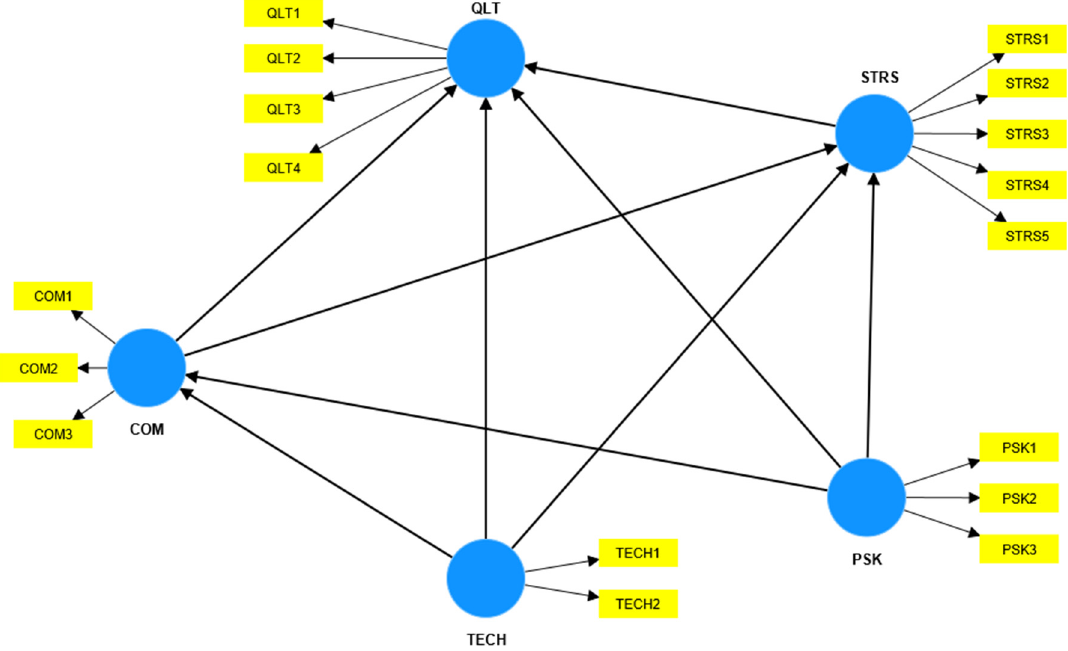
Figure 2. The proposed research model. Source: Designed by authors with SmartPLS version 4. Table 1. The constructs, items, and codes used in the research model.